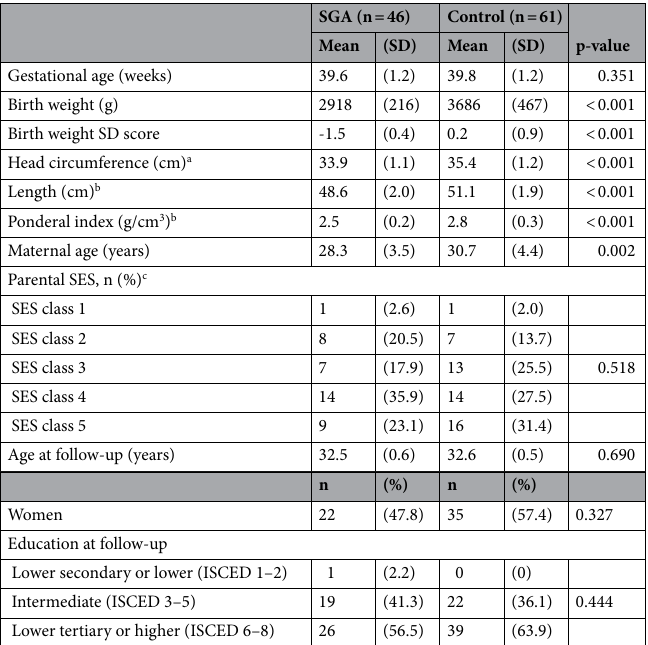
Table 1. Background characteristics of adults born small for gestational age (SGA) and non-SGA (control) at term. ISCED International Standard Classification of Education, SD standard deviation, SES socioeconomic status (1–5, where 5 is highest), SGA small for gestational age. a Data missing for five participants born SGA and four controls. b Data missing for five participants born SGA and three controls. c Data missing for seven participants born SGA and 10 controls. p-values based on Student’s t-test for continuous data and Exact Mann–Whitney U test for ordinal data (i.e., SES and ISCED).